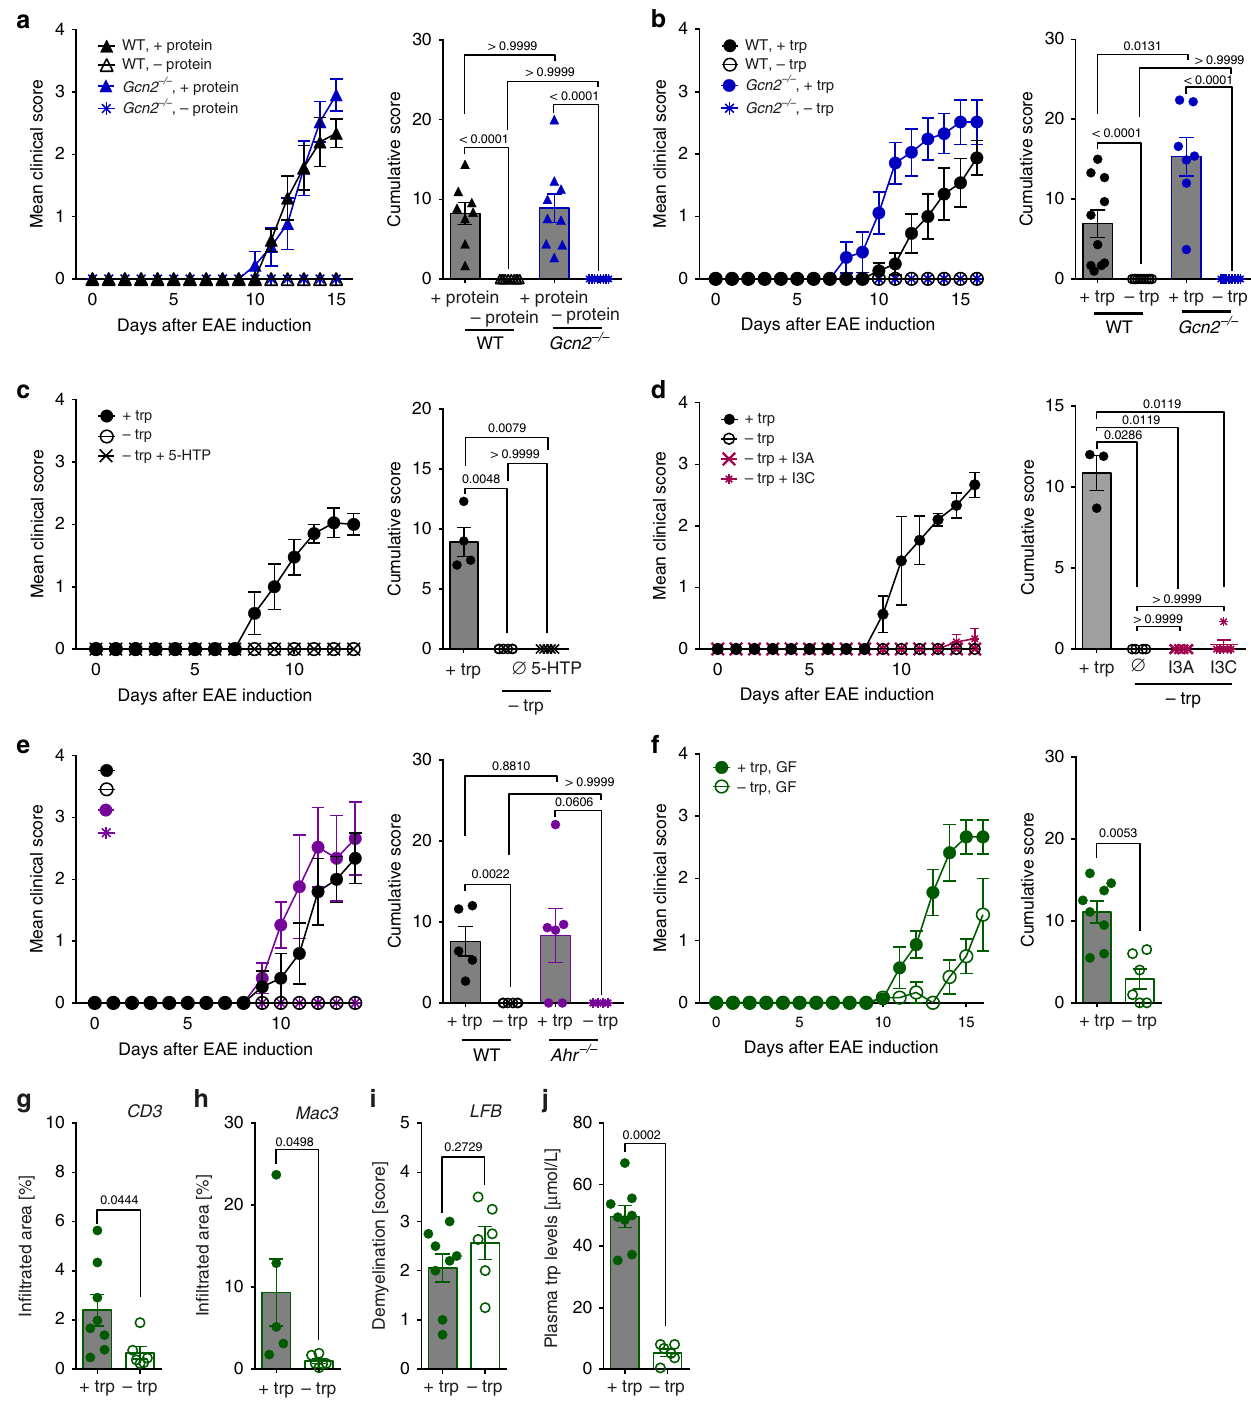
Fig. 4 EAE inhibition driven by DPR and DTR is independent of GCN2 and AHR. a Mean clinical EAE scores and cumulative scores (WT, + protein: n = 8; WT, − protein: n = 10; Gcn2 − / − , + protein: n = 9; Gcn2 − / − , − protein: n = 10). b Mean clinical EAE scores and cumulative scores (WT, + trp: n = 10; WT,